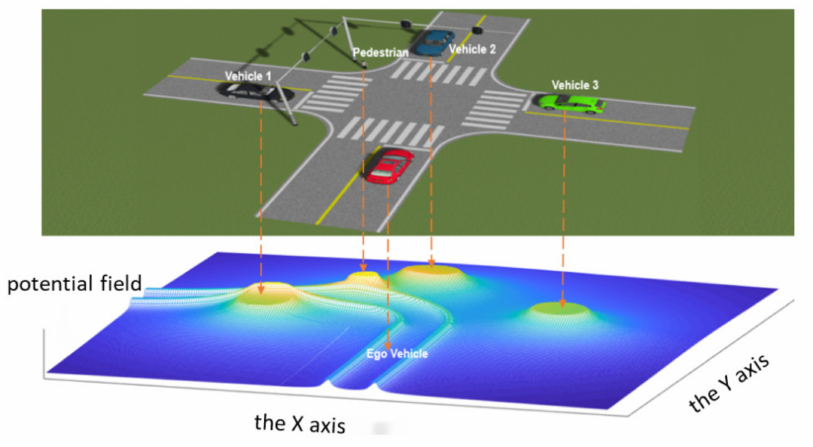
Figure 5. The potential field of the environmental elements at intersection without traffic signal. Compared with the intersection without traffic signal, the intersections with traffic signal have the strong constraint effect of traffic signal lights, Vehicles 1 and 3 have no traffic conflicts with the autonomous vehicle; thus, it is necessary to attenuate the potential field generated by them. The potential field of each environmental element at the intersection is shown in Figure 6. The “peak” of the potential energy field generated by Vehicles 1 and 3 becomes lower than that of Vehicle 2 and the